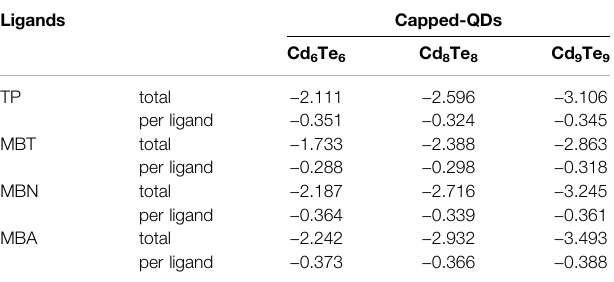
TABLE4| Ligand ’ stotalnetchargechangeandnetchargechangeperligand(ine unit) for capped Cd n Te n L n ( n (cid:1) 6, 8, and 9) QDs (where L (cid:1) TP, MBT, MBN, and MBA) calculated with B3LYP/Lanl2dz approach in the gas